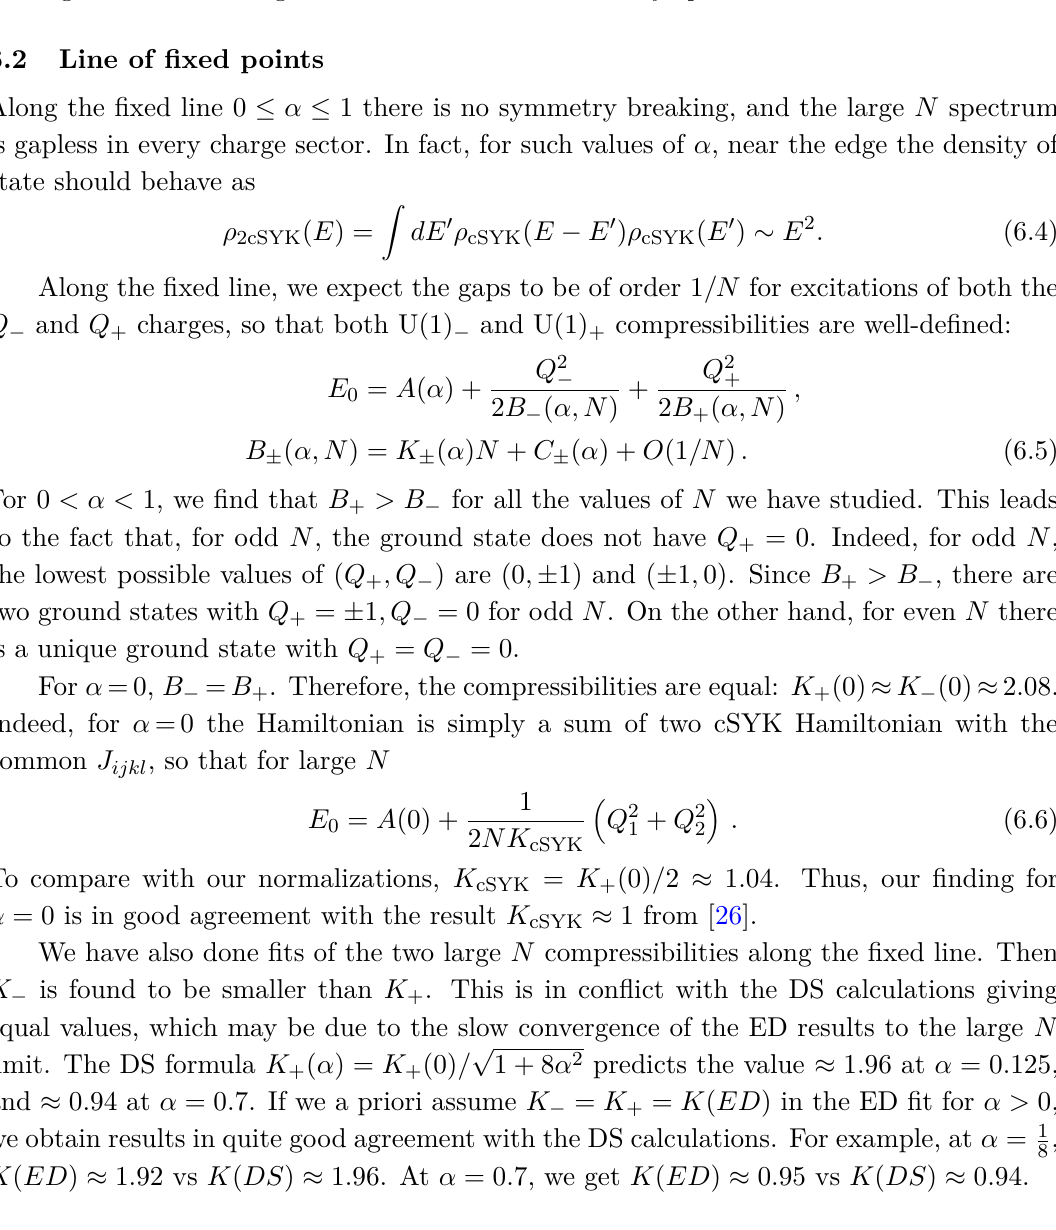
Figure 12 . Comparison of the ED and DS calculations of E 0 ( α ) = lim N →∞ E 0 ( α ) /N . They show good agreement even though the ED results are available only up to a moderate values of N